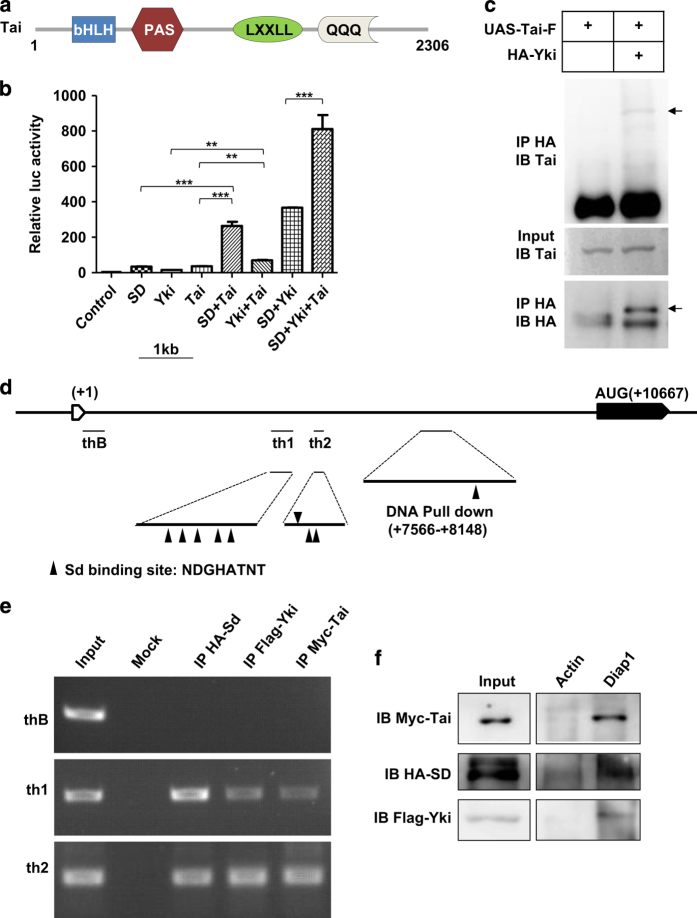
Tai binds to Yki and forms a complex with Sd-Yki on target gene promoter. (a) Schematic diagram of the Tai protein domain structure. (b) Tai acts synergistically with Sd-Yki to activate 3xSd2-luc reporter gene. S2 cells were transfected with indicated constructs and luciferase reporter gene, followed by dual luciferase assay. The data were quantified using an unpaired t-test. The results represented the mean± s.e.m. ***P<0.001 (n=3). (c) CoIP of Tai with HA-tagged Yki. S2 cells were transfected with the indicated Tai and Yki constructs, followed by immunoprecipitation and western blot analysis with the indicated antibodies. The specific bands were indicated by arrows. (d) Diagram of the diap1 promoter. Fragments for ChIP analysis and DNA pull-down are marked. Sd-binding motifs were indicated by arrowheads. th1 and th2 stand for the two regions containing several Sd-binding motifs. thB is the negative control. The biotin-tagged DNA fragment (7566-8148) also contains Sd-binding motif. (e) Tai binds to the promoter of diap1. Cells were transfected with HA-Sd, Flag-Yki and Myc-Tai, followed by ChIP assay with indicated antibodies. HA-Sd was added in as a positive control. (f) Tai, Sd and Yki bind to diap1 DNA sequences but not to actin. DNA pull-down with either actin or diap1 DNA sequences from extracts of S2 cells transfected with Myc-Tai, Flag-Yki and HA-Sd.